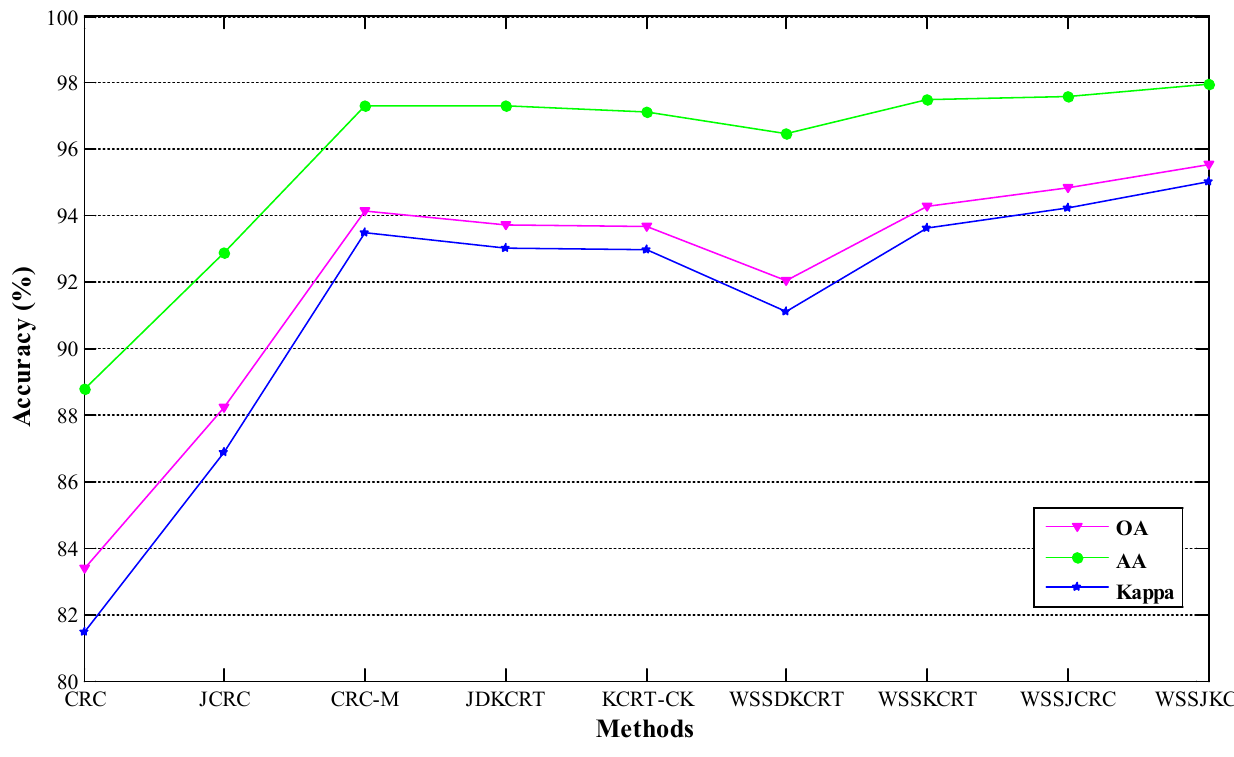
Figure 13. Land cover classification maps generated by different methods on the Pavia University scene: ( a ) ground truth, ( b ) CRC, ( c ) JCRC, ( d ) CRC-M, ( e ) JDKCRT, ( f ) KCRT-CK, ( g ) WSSDKCRT, ( h ) WSSKCRT, ( i ) WSSJCRC, and ( j ) WSSJKCRC.